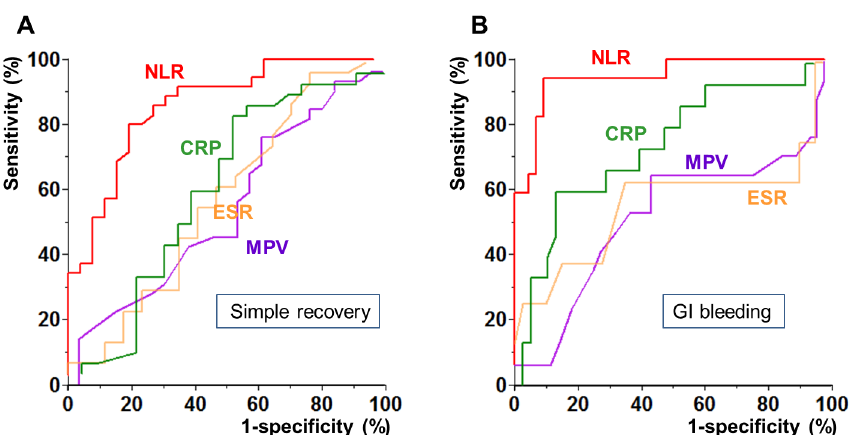
Fig 2. Receiver operating characteristics curves for predicting simple recovery (A) and development of GI bleeding (B). GI,